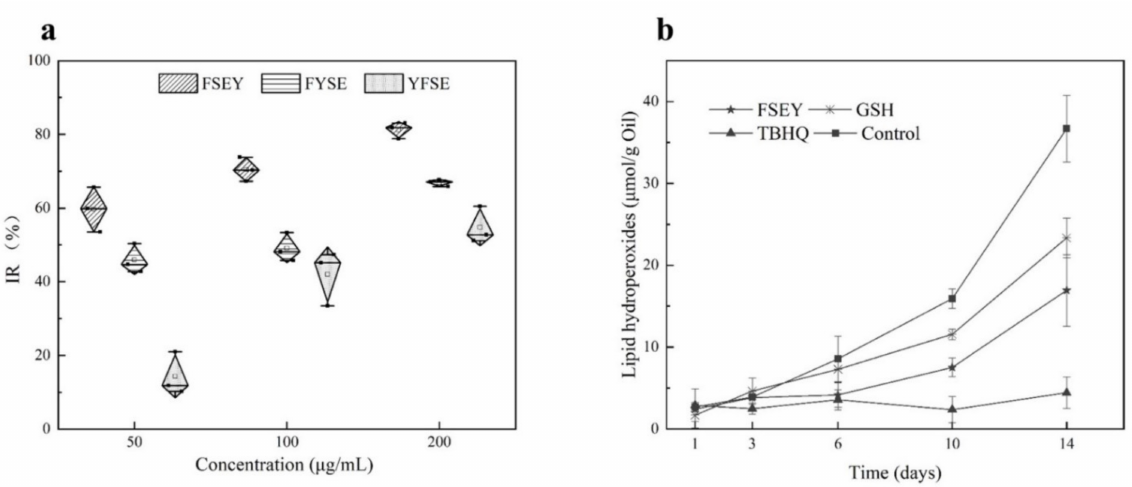
Figure 4. Antioxidant activities of peptides. ( a ) stands for activities of FSEY, FYSE, and YFSE on the oxidation of linoleic acid; ( b ) represents the effects of the antioxidants on oil oxidation, GSH and TBHQ as positive